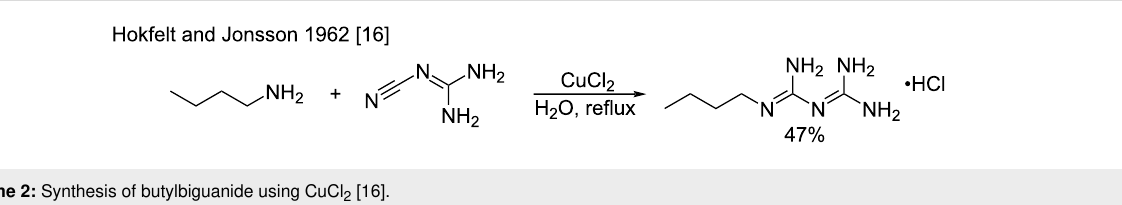
Scheme 2: Synthesis of butylbiguanide using CuCl 2